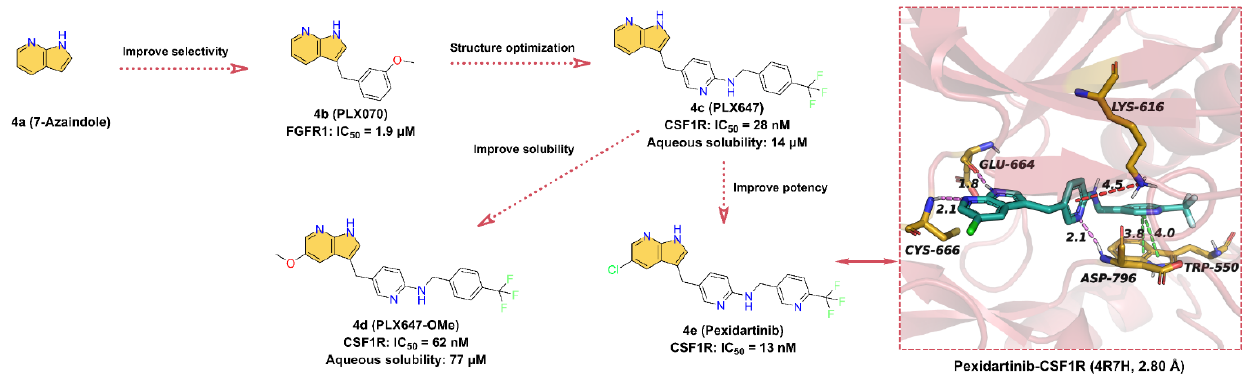
Figure 4. Key medicinal chemistry optimization of Pexidartinib along with the binding model with